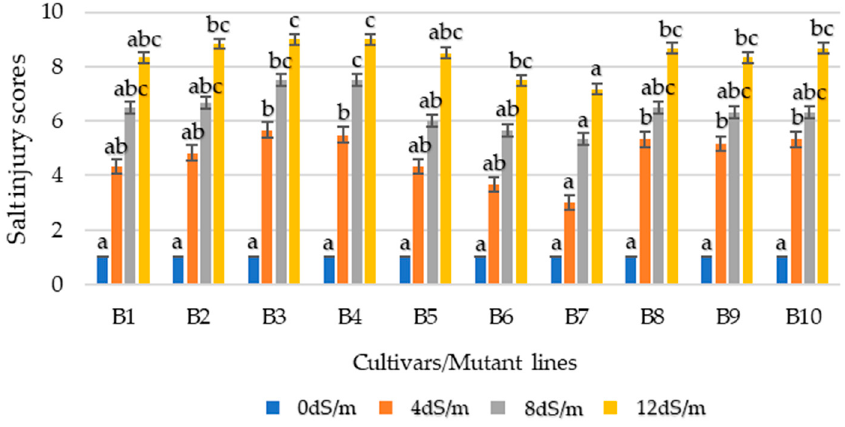
Figure 1. Salt injury scores of rice samples at different levels of salinity. Values represent mean of scores ; different letters in a salinity level indicate a significant difference ( P < 0.05) by Tukey’s test.